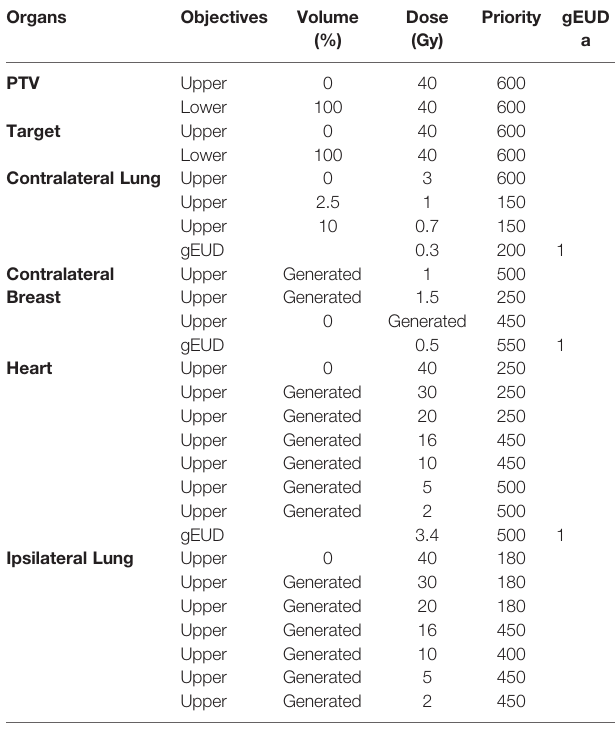
TABLE 3 | The KB-based template for automatic planning optimization for the ViTAT technique for left-sided breast cancer treatment. Organs